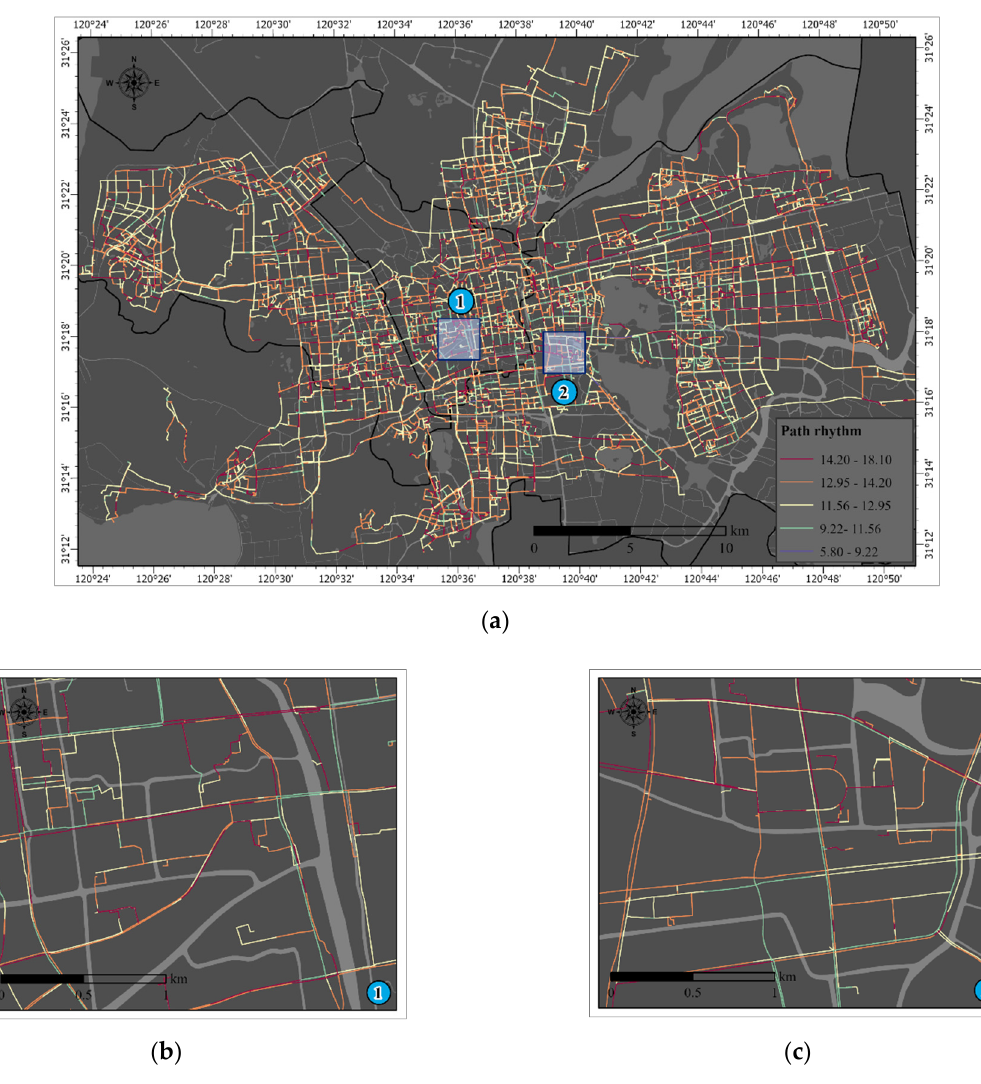
Figure 7. Distribution of cycling rhythm with a focus on paths. ( a ) overall cycling rhythm of paths in urban area; ( b ) bidirectional inconsistency in cycling rhythm in Gusu District; ( c ) bidirectional inconsistency in cycling rhythm in Wuzhong District.